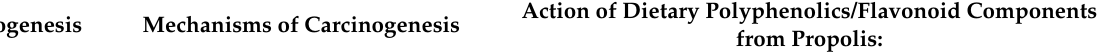
Table 2. Stages of carcinogenesis inhibited by propolis and its polyphenolics/flavonoids and the possible molecular mechanisms of their biological